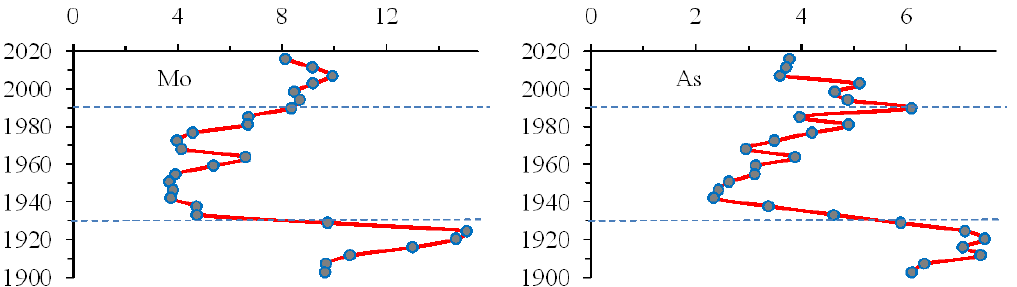
Figure 9. Vertical distribution of the content (µg/g) of Mo and As in the sediments of Lake Bolshoy Vudjavr.